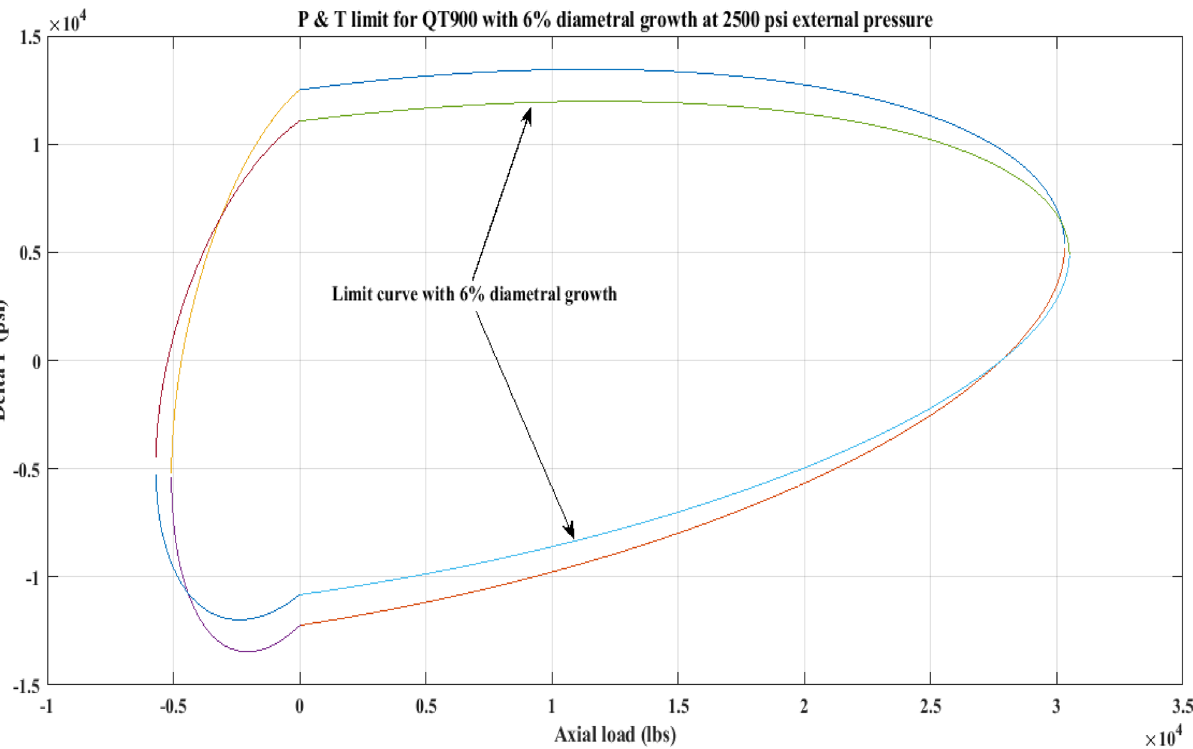
Figure 11. P and T limit with diameter growth for QT 900 at 2500 psi P o .